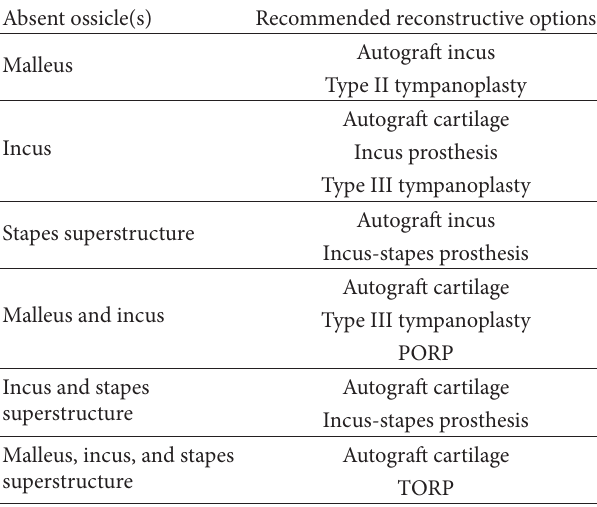
Table 2: Reconstructive options for ossicular chain discontinuity (adapted from Bhatti and Bluestone [11], surgical atlas of paediatric otolaryngology pages